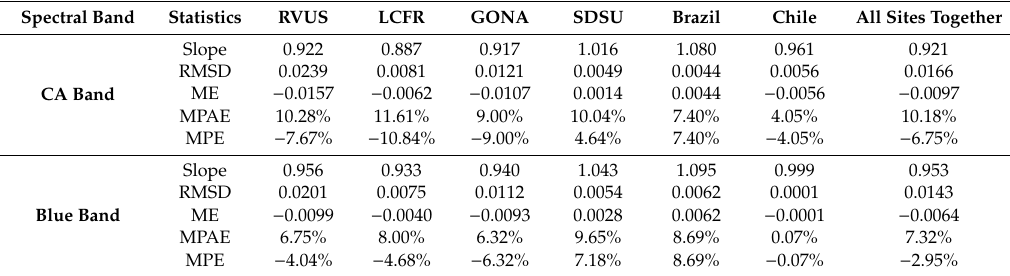
Figure 18. Temporal trends, by band, of residuals (errors) in surface reflectance predicted from in situ measurement and Landsat-8 OLI Level-2 surface reflectance data. Table 5. Comparison between surface reflectance predicted from in situ measurement and the Landsat-8 OLI data Level-2 surface reflectance data (Root Mean Square Deviation—RMSD, Mean Error—ME, Mean Percent Error—MPE; Mean Percent Absolute